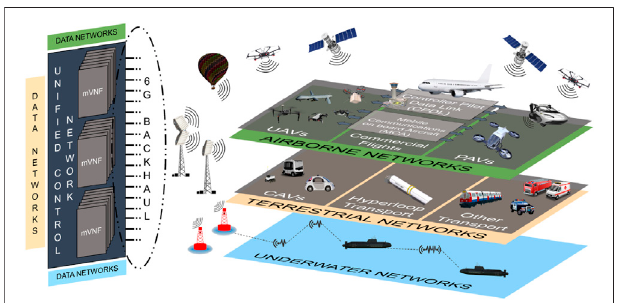
FIGURE2| Envisaged Hierarchical 6G Architecturefor airborne, ground and underwater networks with a distributed data backhaul including massive Virtual Network Functions and a uni fi ed control